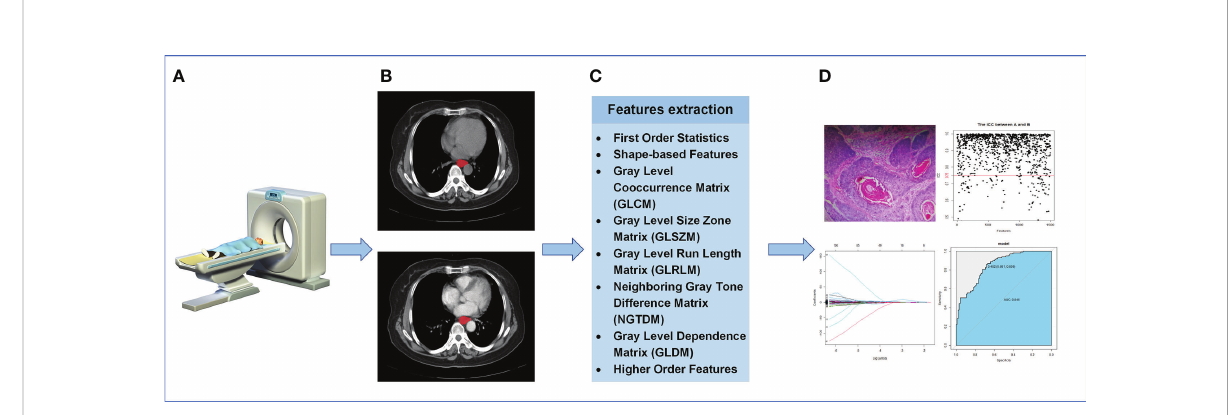
FIGURE 2 The process of radiomics. (A) Acquisition of CT images. (B) Segmentation of ROI. (C) Extraction of ROI feature. (D) Statistical